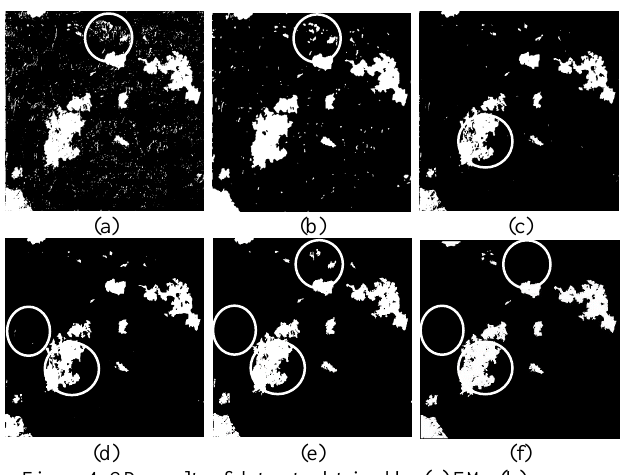
Figure 4. CD results of datasets obtained by (a) EM, (b) EMMRF, (c) MLS, (d) FLICM, (e) proposed method, and (f) is the ground reference map.